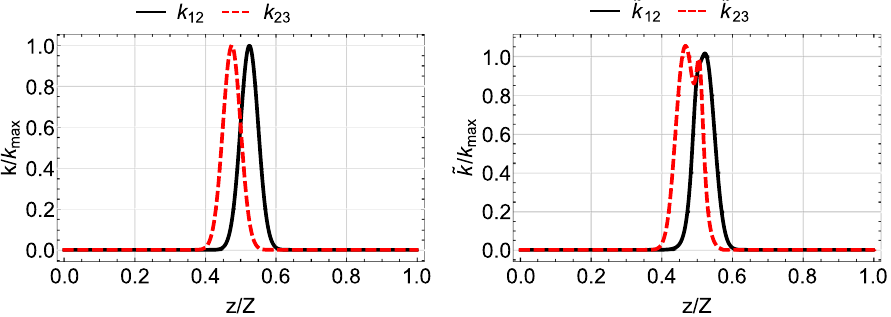
Figure 10. Gaussian (left column) and modified shortcut (right column) coupling coefficients for parameters 1 , τ Z Z / 40 and ζ = Z / 28 2 mm 30 mm, k 0 − = = =